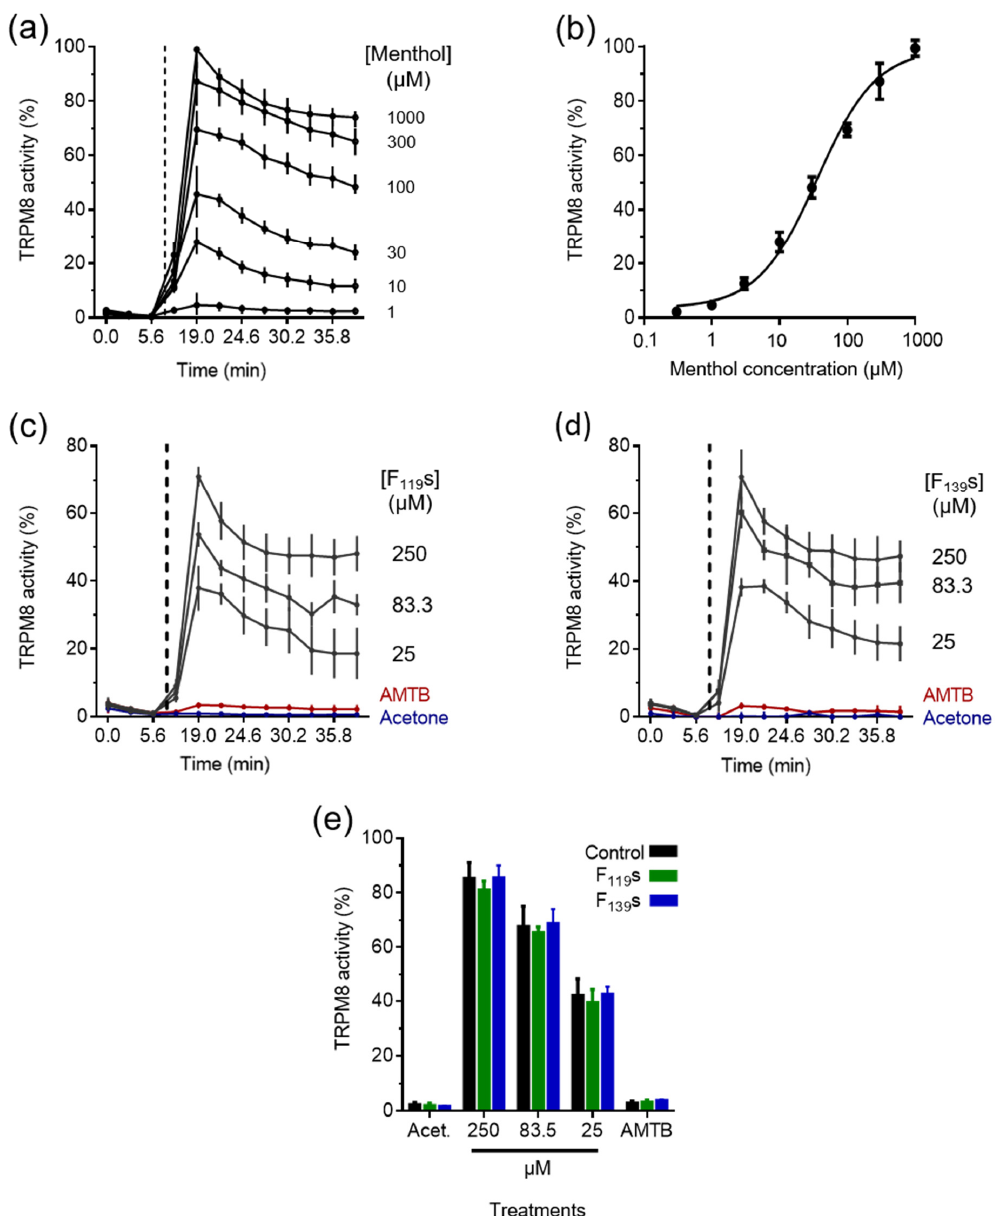
Figure 5. Activation of TRPM8 by the menthol contained in electrospun F 119 s and F 139 s in HEK293-hTRPM8 cells. All data correspond to intracellular Ca 2+ measurements and are represented as mean percentages with standard deviation of the maximum response observed for each treatment to that of 1000 μ M menthol ( n = 3). ( a ) Representative dynamics of the intracellular Ca 2+ in response to different menthol concentrations. ( b ) Dose–response curve to menthol. ( c , d ) Representative dynamics of the intracellular Ca 2+ in response to different concentrations of menthol encapsulated in F 119 s and F 139 s, respectively. ( e ) Intracellular Ca 2+ increases recorded in response to 250, 83.3, and 25 μ M of free and encapsulated menthol, including as controls: samples without menthol and 0.05% acetone (Acet.), and the specific TRPM8 blocker AMTB at 10 μ M against 83.3 μ M menthol samples. Statistical analysis calculated from the datasets in ( e ) comprised two-way ANOVA corrected with Tukey’s test for multiple comparisons, but no significant differences were found between the treatment groups at each concentration.